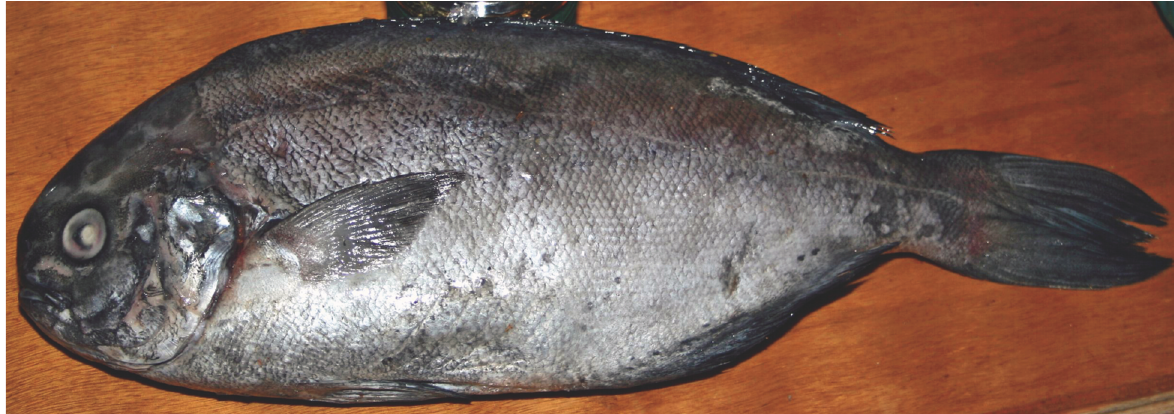
Fig. 1. The freshly caught specimen of Schedophilus ovalis from the Aegean Sea (Photo: S.